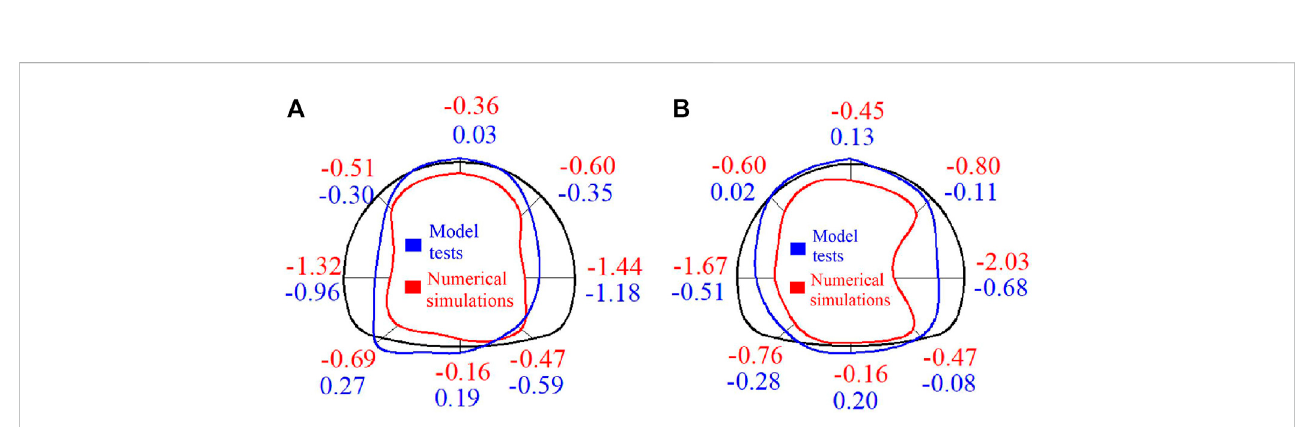
FIGURE 15 Thirdprincipalstressofliningstructureinnumericalsimulationsandmodeltests(unit:MPa): (A) Stressoutsidetheliningstructureand (B) Stressinsidethe lining